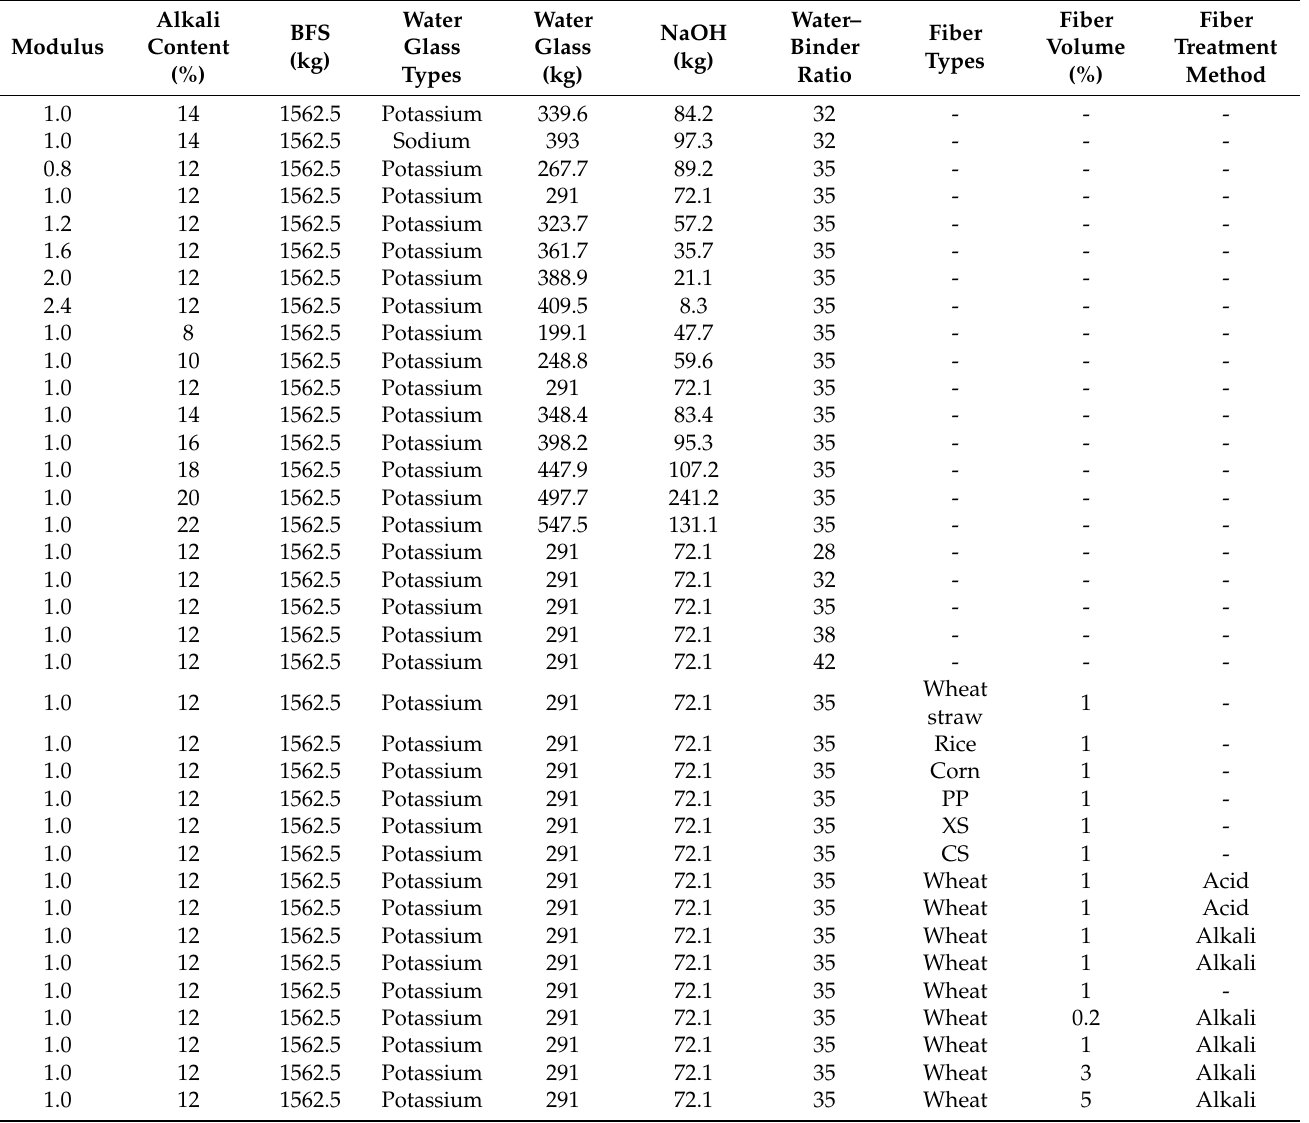
Table 2. The mixing proportions of alkali-activated BFS